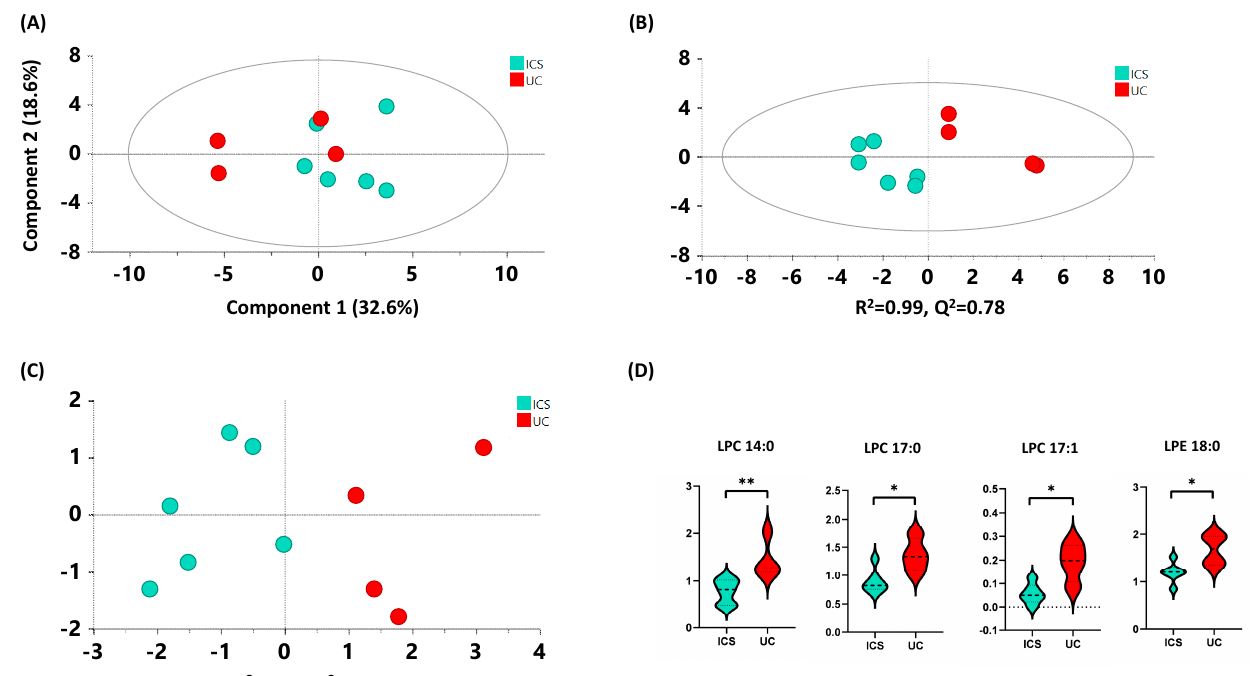
Figure 3. ( A ) PCA model, ( B ) PLS-DA model, and ( C ) CV-OPLS-DA model for ICS vs. UC comparison. Data were UV scaled. R 2 is the capability of the model to classify the samples; Q 2 is the capability of the model to predict the class of a new simple. ( D ) Significant metabolites between the ICS and UC groups. (Key: “ICS”: blue, “UC”: red). * p < 0.05; ** p <